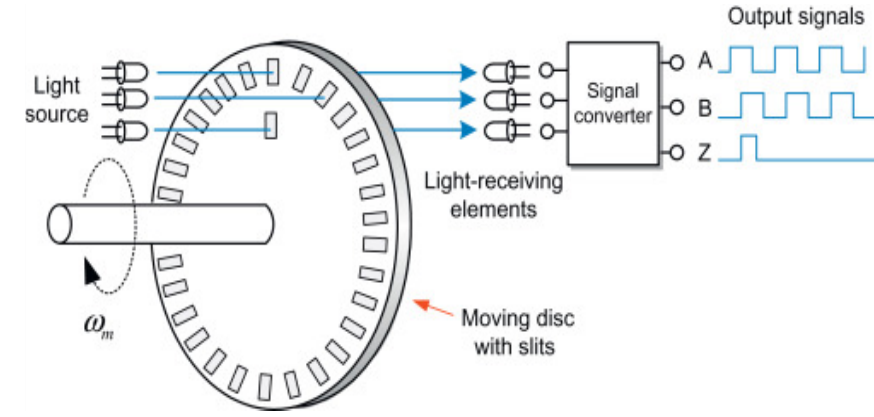
Figure 7. The operation of the rotary incremental encoder.